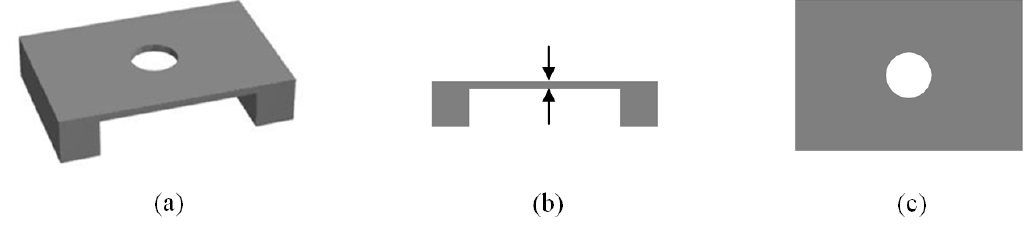
Figure 3. A graphic model of test specimen to optimize the stereolithographic process parameters ( a ). Layer thicknesses of photo polymerization depths ( b ) and size tolerances of exposure right scattering ( c ) were